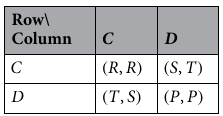
Table 1. Pay-off table of the two-person two-strategy game.